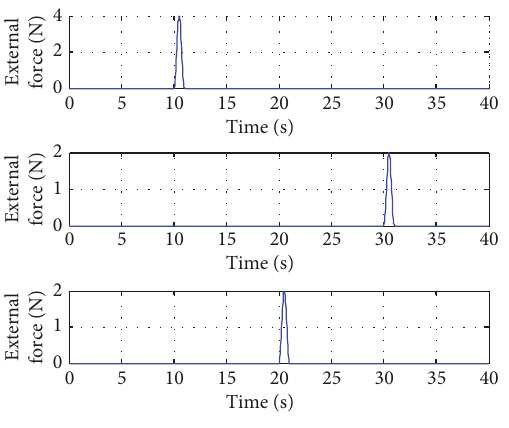
Figure 10: Disturbance term curves. Table 2: Parameters used in this simulation. Parameter